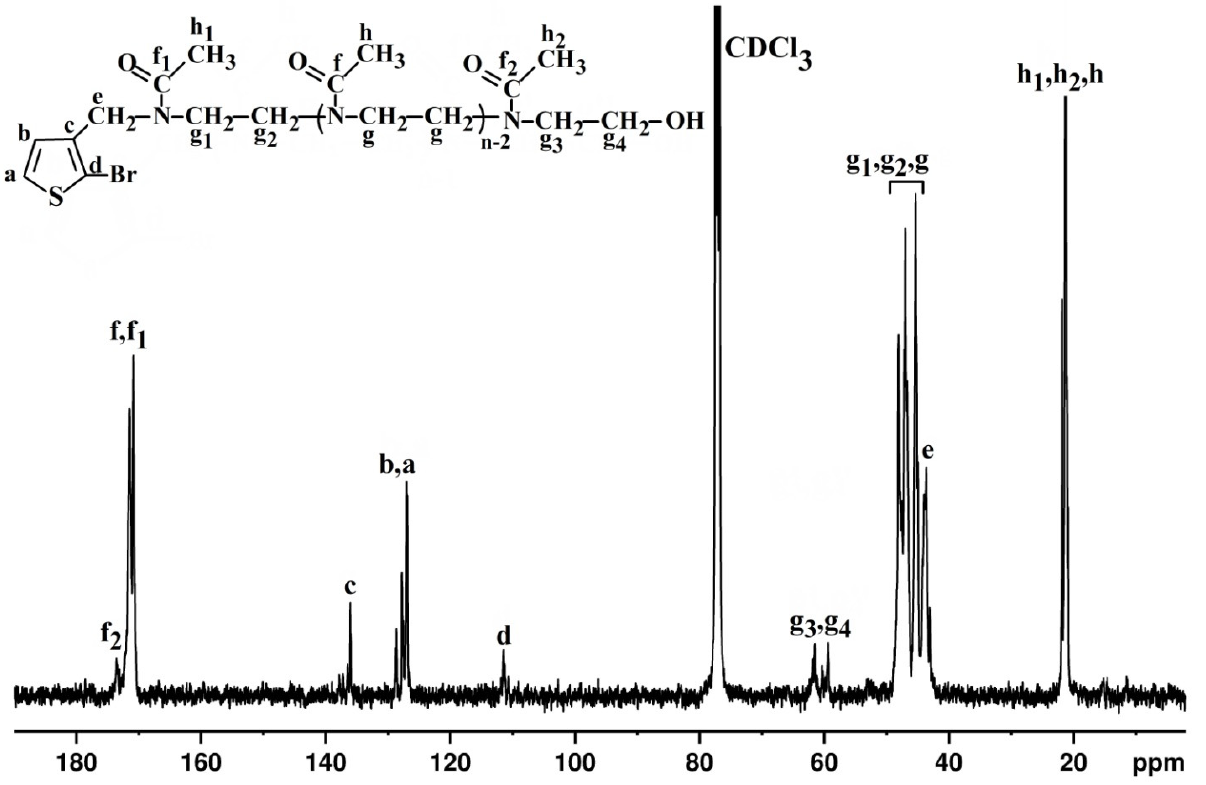
Figure 2. The 13 C-NMR spectrum of Th-OMeOx macromonomer registered in CDCl 3 .